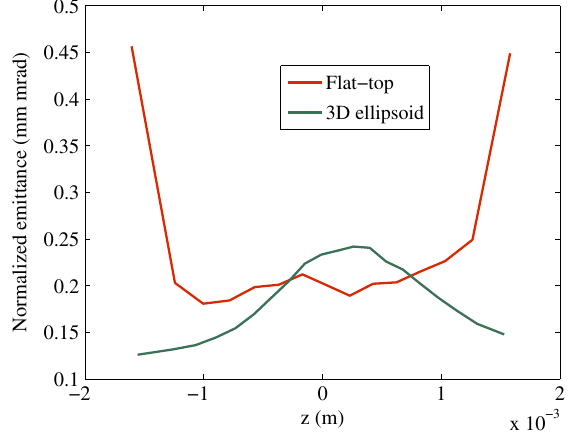
FIG. 12. Emittance along the bunch for the 3D ellipsoid and the flat-top optimized distribution. At the highest peak current of the 3D distribution corresponds the emittance of the PSI gun configuration.